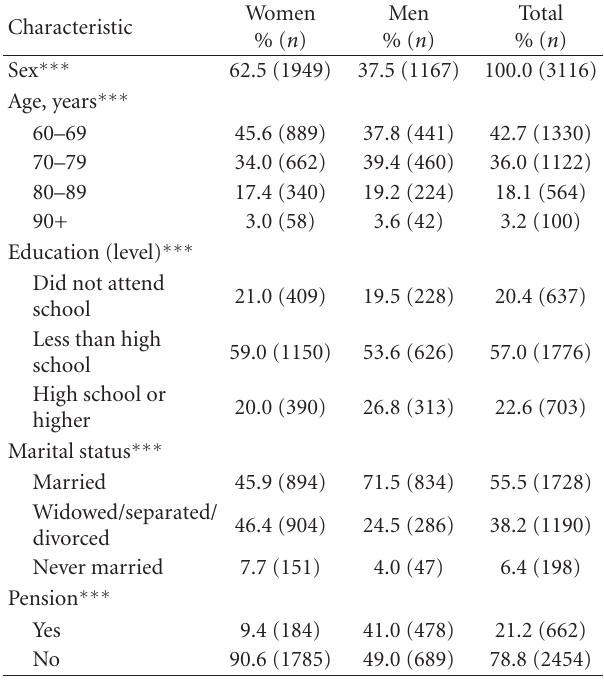
Table 1: Socio-demographic Characteristic by Sex. Table 2: Percentage of older adults meeting each individual suc- cessful aging criterion and total percentage.